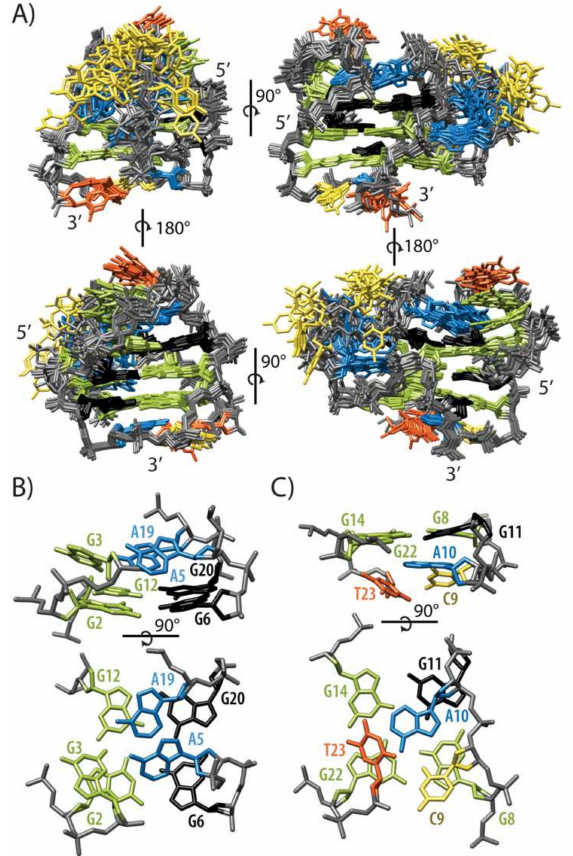
Figure 3. Structure of HPV52 (1–4) . ( A ) Superposition of 10 lowest-energy structures of HPV52 (1–4) . ( B ) Capping structure formed by G3, A5 and A19. ( C ) Capping structure formed by C9, A10 and T23. Guanine residues in syn and anti -conformation, thymine, adenine and cytosine residues are shown in black, green, orange, blue and yellow colour, respectively. DNA backbone is shown in